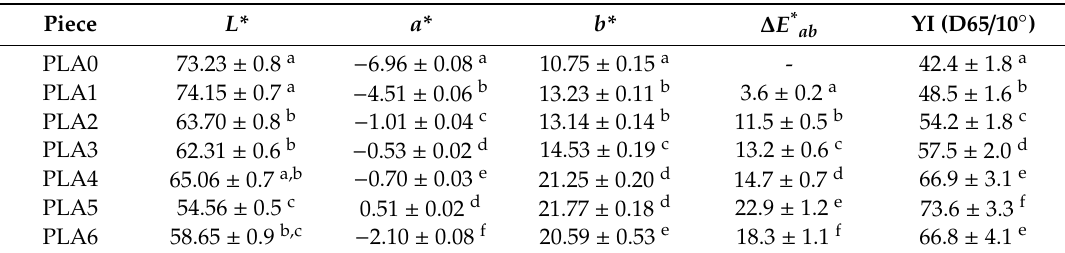
Table 5. Color parameters ( L*, a*, b*, and Δ E *ab ) and yellowness index (YI) of the injection-molded polylactide (PLA) pieces subjected to different reprocessing cycles.